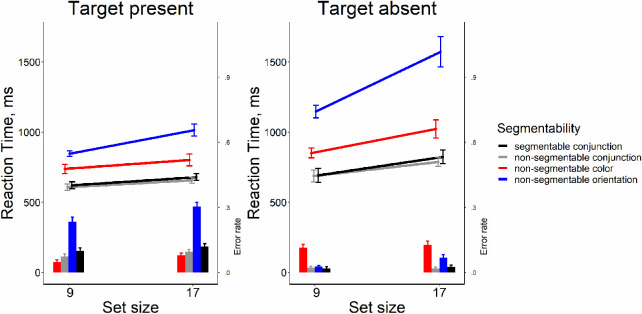
Reaction time and error rate as a function of set size and task in Experiment 4. Error bars denote the SEM, with between-subject variance removed in accordance with the Cousineau (2005) method.